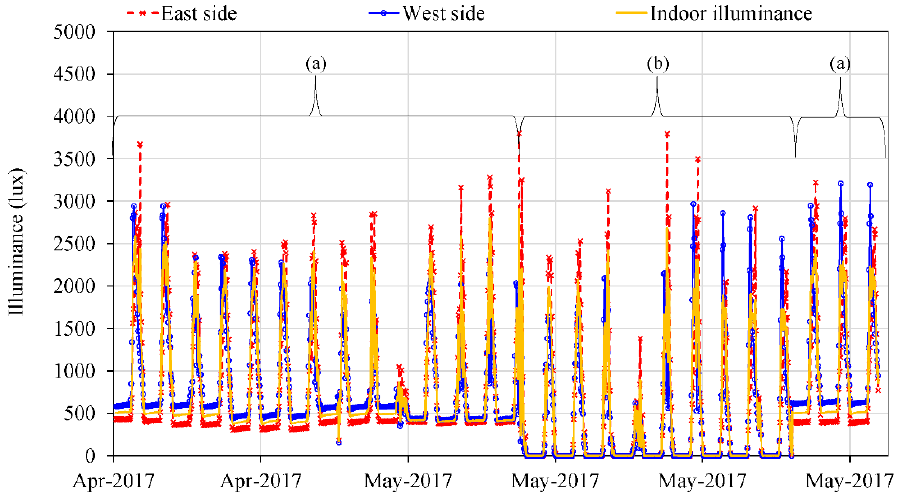
Figure 10. Indoor illuminance distribution of the passive solar building.